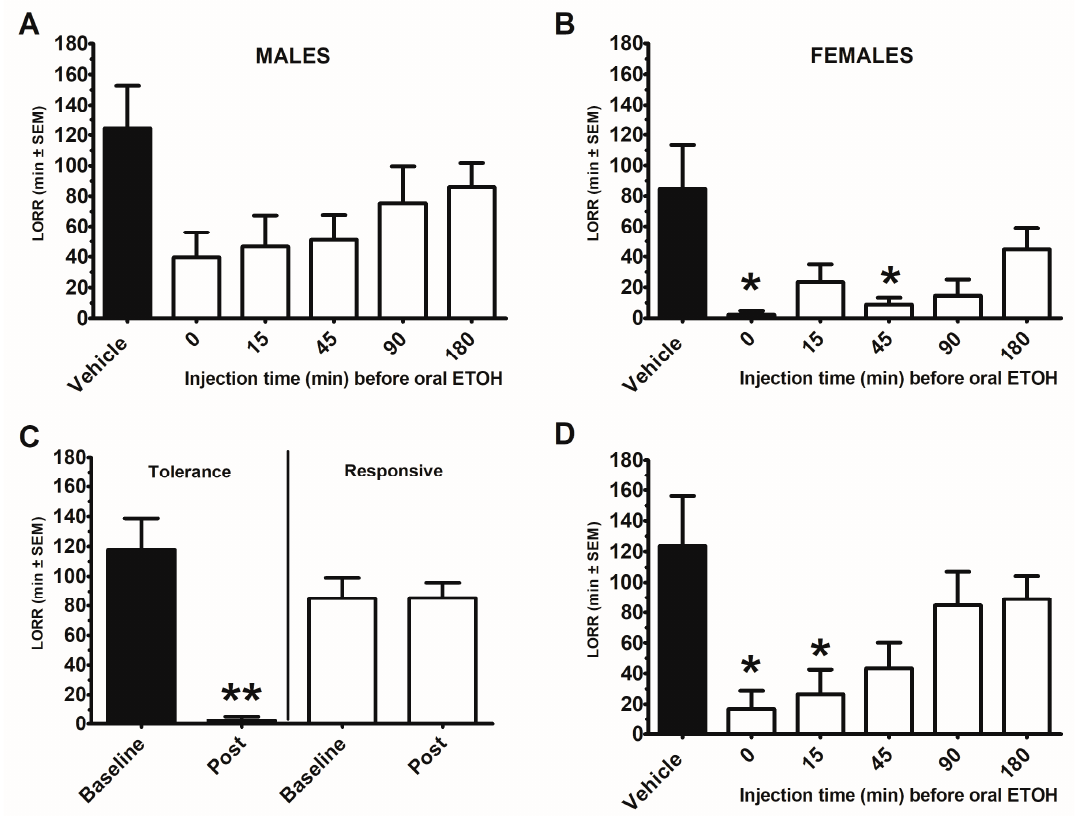
Figure 1. Dihydromyricetin (DHM) time course for attenuating the loss of righting reflex (LORR) following acute oral gavage of ethanol (5 g/kg) in male and female 8-week-old C57BL/6J mice. Each mouse received an IP injection of DHM or vehicle (10% DMSO) at a time prior to an oral gavage of ethanol (ETOH). Each time point (0, 15, 45, 90, 180 min) or vehicle was 1 week apart for a total of 6 weeks. ( A ) Males ( n = 8), ( B ) Female ( n = 8). To determine whether the observed DHM effects were a consequence of repeated oral ETOH tolerance, mice were tested for LORR responsivity prior to (Baseline) and after (Post) the 6-week repeated IP dosing schedule. For this, mice received an oral ETOH without any IP injections. Mice were divided by the significant difference in baseline and post LORR. ( C ) Mice demonstrating a significantly reduced LORR displayed tolerance ( n = 8; 3 males/5 females), whereas mice that retained the LORR were responsive ( n = 8; 5 males/3 females). ( D ): Time course of DHM on LORR in Responsive only mice. * indicates p < 0.05 from vehicle treated condition. ** indicates p < 0.005 from baseline. Table 1. Pharmacokinetic parameters, including serum elimination half-life (T 1/2 ), maximum